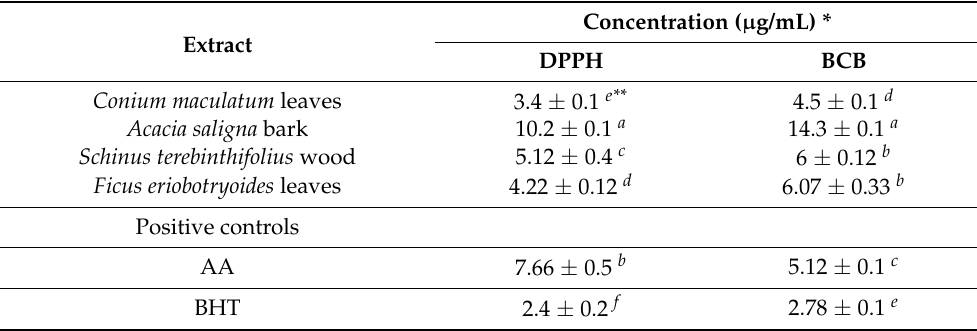
Table 4. Antioxidant activity of four extracts measured by DPPH and β -carotene-linoleic acid assays. Extract Conium maculatum leaves Acacia saligna bark Schinus terebinthifolius